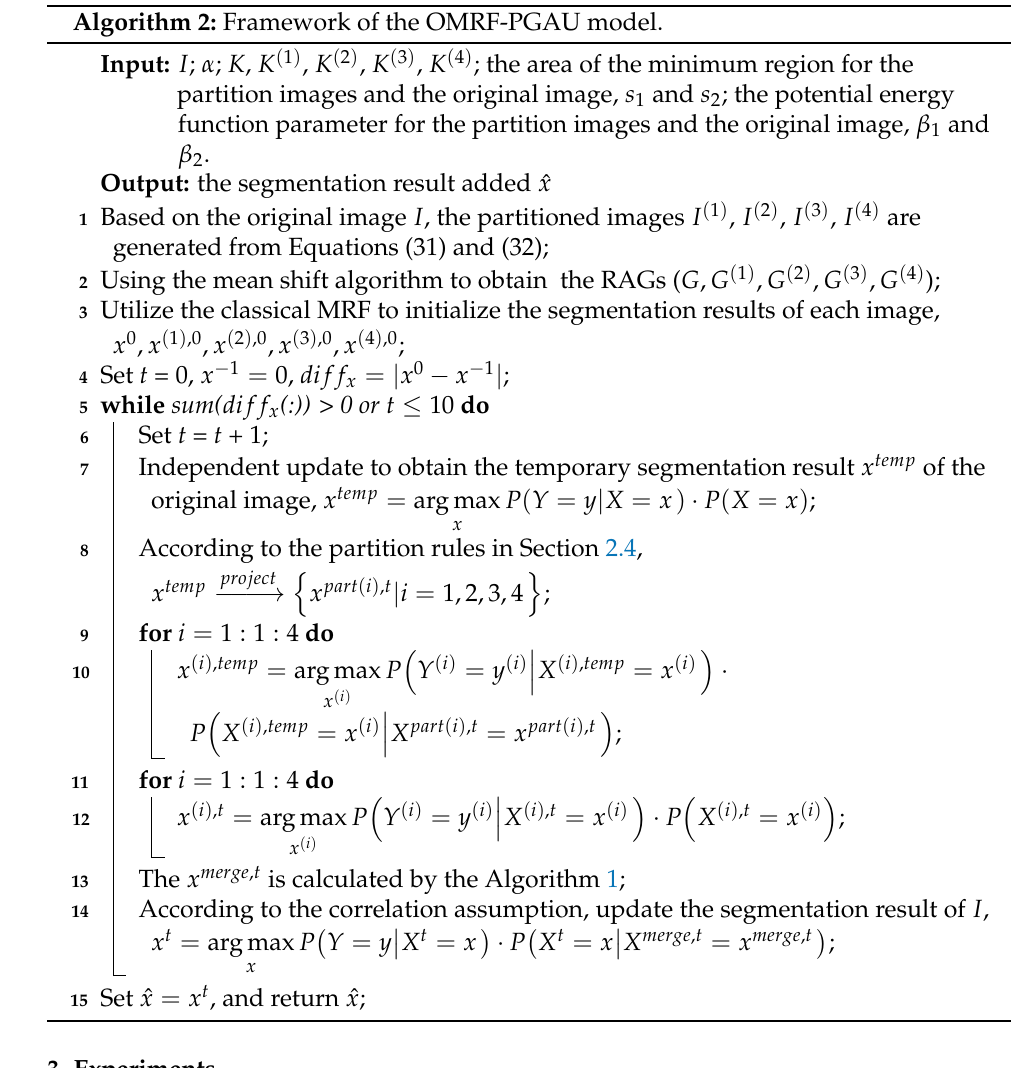
Algorithm 2: Framework of the OMRF-PGAU